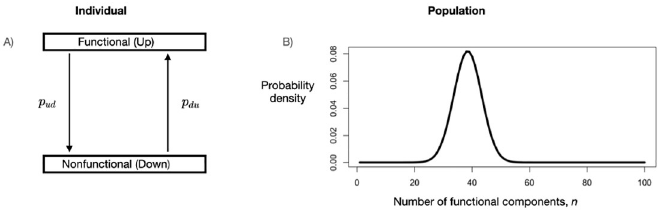
Fig 1. Visual description of the problem when the system has only two possible states. An individual cyber component can be either functional (“up”) or nonfunctional (“down”). A) Individual components transition between the two states according to a Markov process in which p is the probability that an individual component that is ud currently functional is nonfunctional at the next time step and p du is the probability that a component that is currently nonfunctional is functional at the next time step. B) Although individual components will in general continue to fluctuate between functional and nonfunctional states, after a sufficient length of time a population of components will settle into a probability distribution for the number of functional components. Our goal is to characterize this probability distribution and the factors determining how rapidly it is